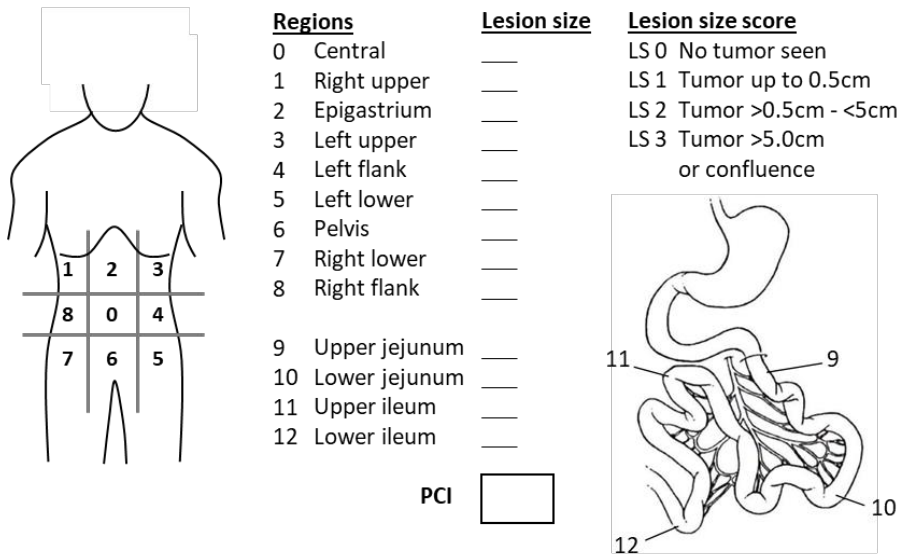
Figure 1. Peritoneal Cancer Index (PCI) . Each region (total of 13 regions) should be scored based on the largest tumor present. All 13 scores should be added to a total Peritoneal Cancer Index (PCI), ranging from 0 to 39.